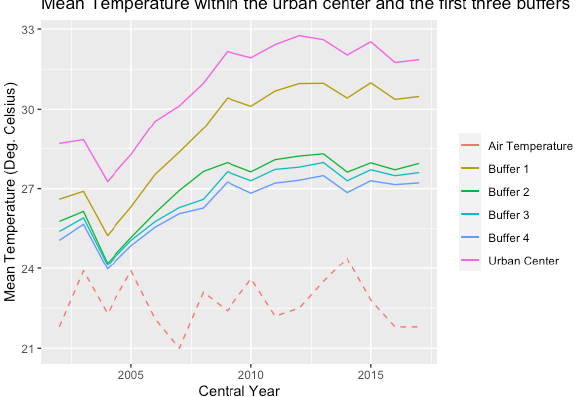
Figure 3 . The mean LST collected within each time period within the urban centre and the first four buffers. Daily air temperature data from the nearest station to Milton, in Georgetown, is applied to separate the local UHI effects from regional climate